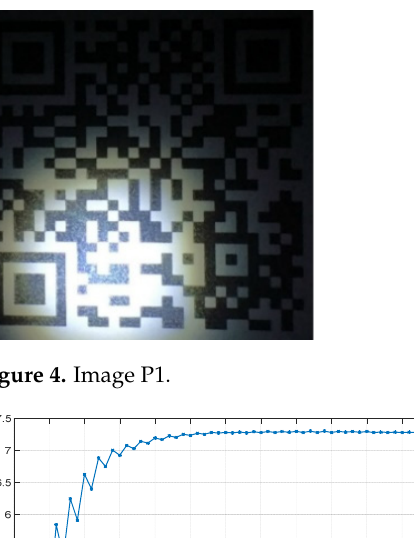
Figure 3. Flowchart of pre-processing.